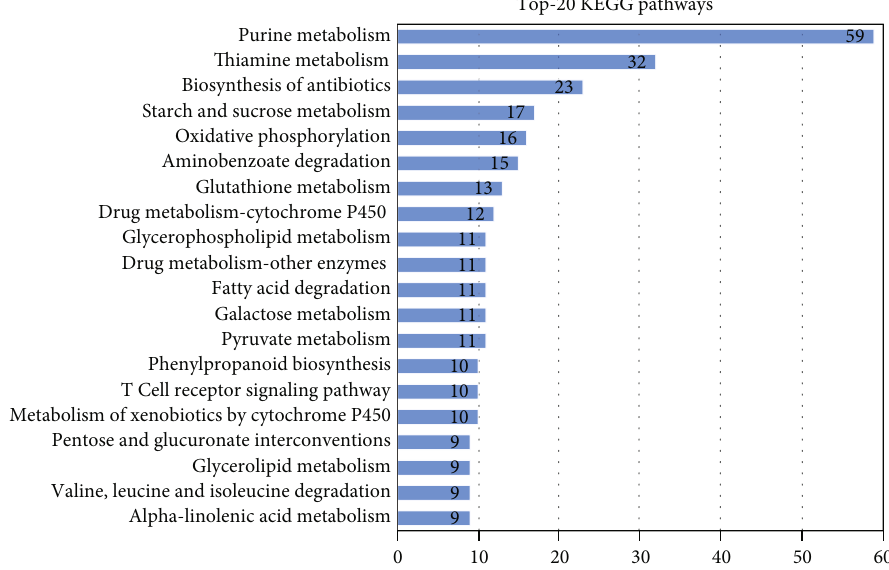
Figure 3: The top 20 KEGG pathways assignments in upregulated heat stress-responsive unigenes. The number of unigenes predicted to belong to each category is shown.